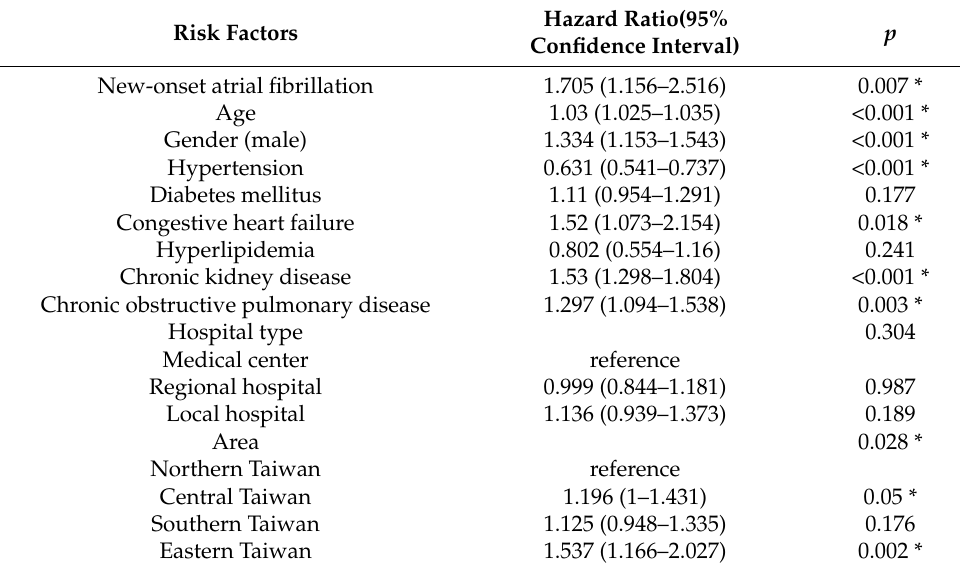
Table 2. Risk factors for major adverse cardiovascular events in septicemia